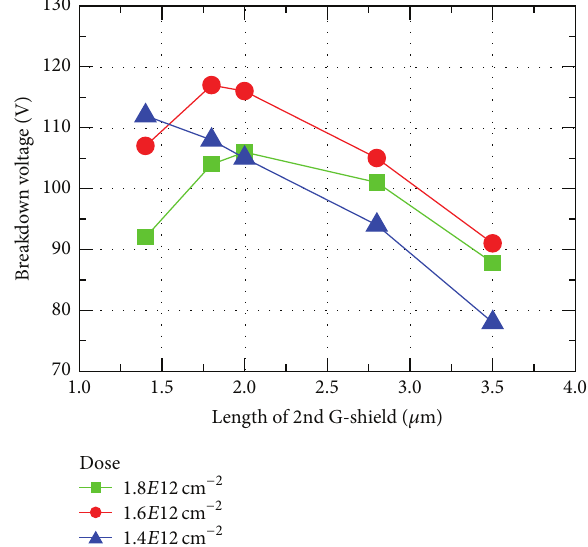
Figure 7: Silicon data of the effect of the 2nd G-shield length on the breakdown